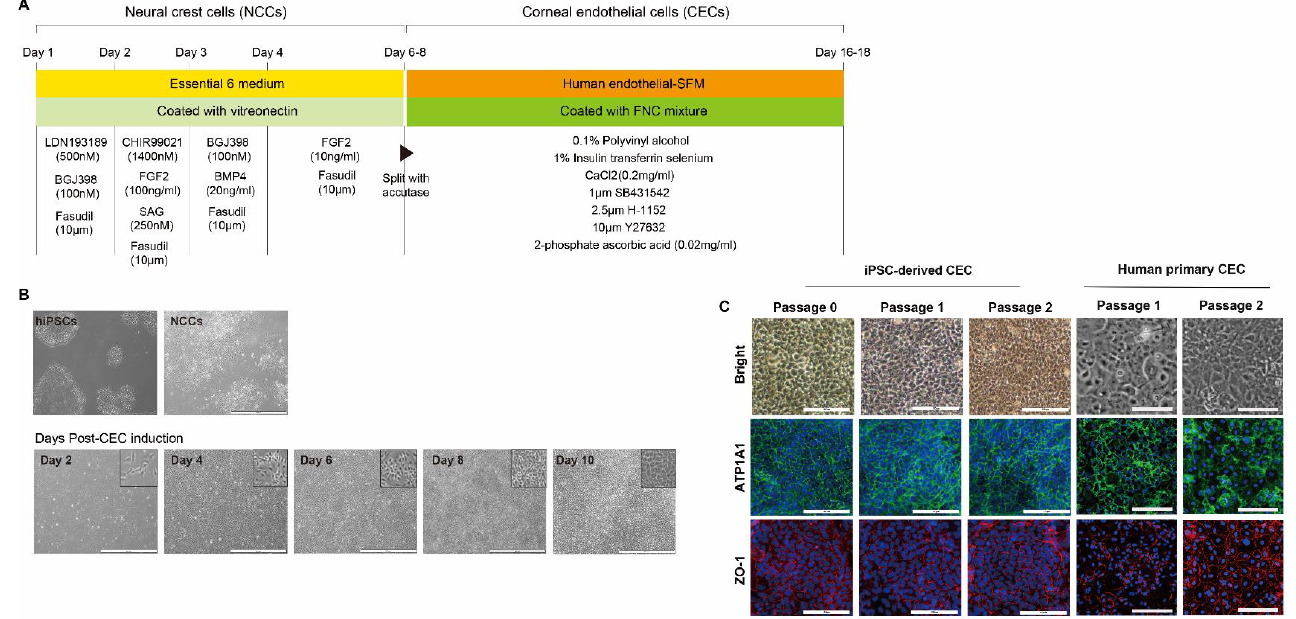
Figure 1. Generation of corneal endothelial cells (CECs) from induced pluripotent stem cells (iPSCs). ( A ) Protocol for differentiation of iPSCs to CECs. iPSCs were differentiated into CECs through neural crest cells for 16–18 days. ( B ) Phase-contrast microscopy at time points during CEC differentiation illustrates likely CECs at day 6, and CECs exhibiting characteristic hexagonal/polygonal morphology at day 10. Scale bars = 500 µ m. ( C ) Immunocytochemistry of pump function protein Na + /K + ATPase α 1 (ATP1A1) and zona occludens-1 (ZO-1; a tight-junction protein) exhibiting hexagonal/polygonal morphology of iPSC-derived CECs. Human primary CEC was used as a control. Cell nuclei were counterstained with DAPI. Scale bars = 100 μm.